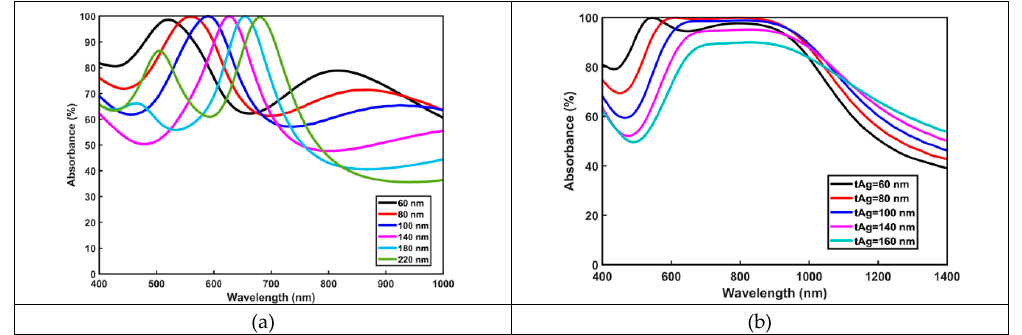
Figure 4. Metamaterial perfect absorbance (MPA) effect by finite-difference time-domain (FDTD) simulation. Reconfigurable perfect absorbance for ( a ) amorphous GST by changing the thickness of Ag nanoarrays from 60 to 220 nm. ( b ) Broadband MPA effect using crystalline GST at Ag thicknesses from 60 to 160 nm.